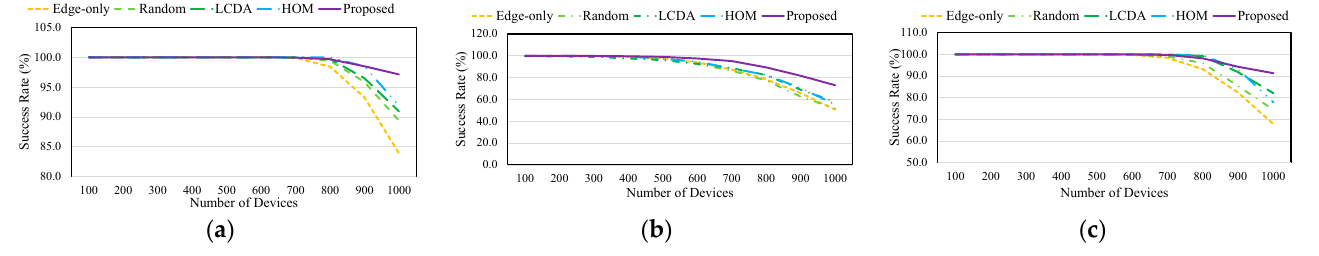
Figure 7. Success rate of Task 1, Task 2, and Task 3: ( a ) Task 1; ( b ) Task 2; ( c ) Task 3.